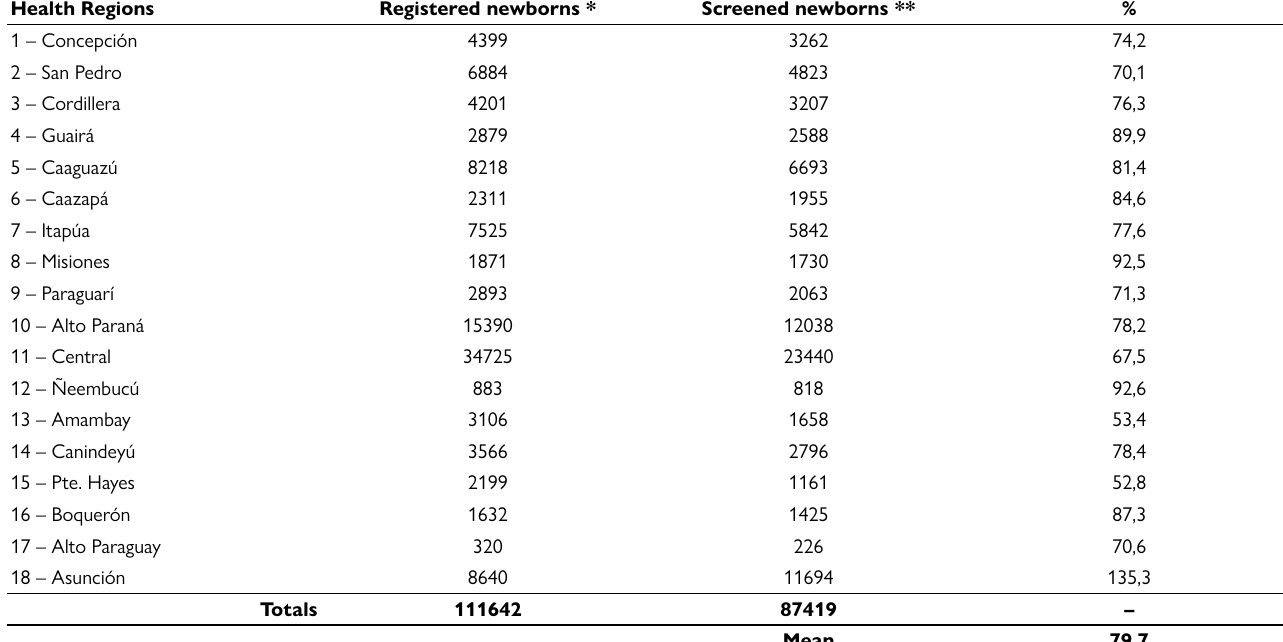
Table 1. Coverage per Health Region. Year 2018.